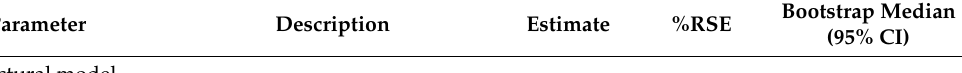
Table 2. Final estimates of population pharmacokinetic parameters.